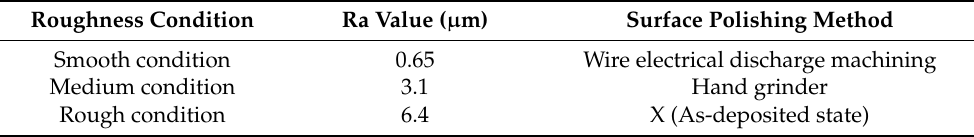
Table 2. Three different conditions of surface roughness used in the experiments. Roughness